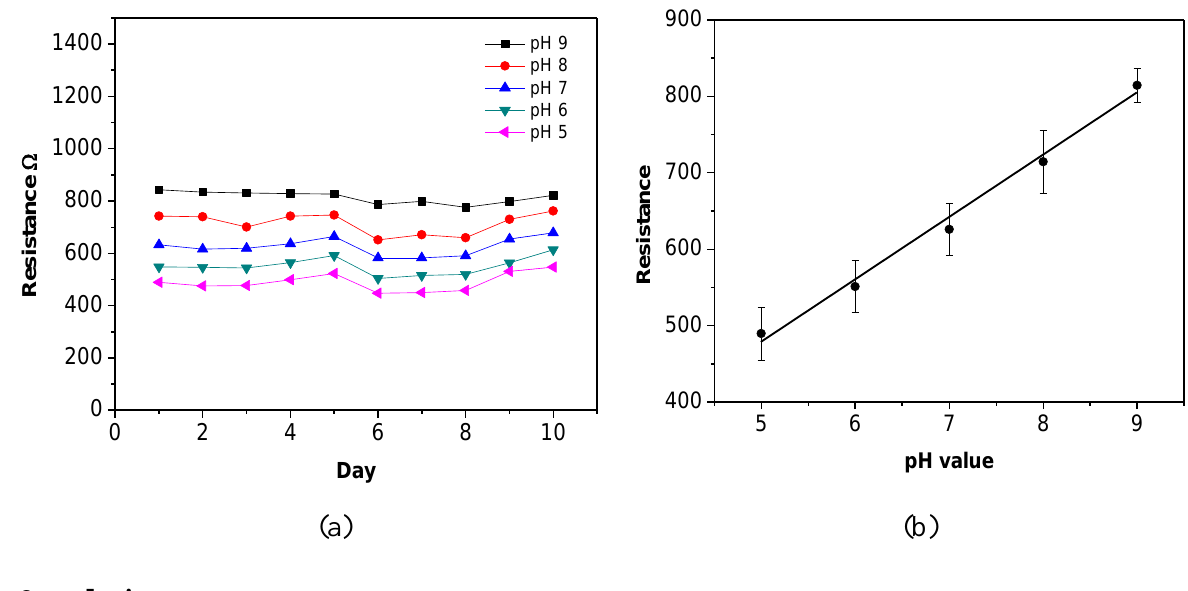
Figure 9. Resistance variation of one sensor in five pH buffer solutions in 10